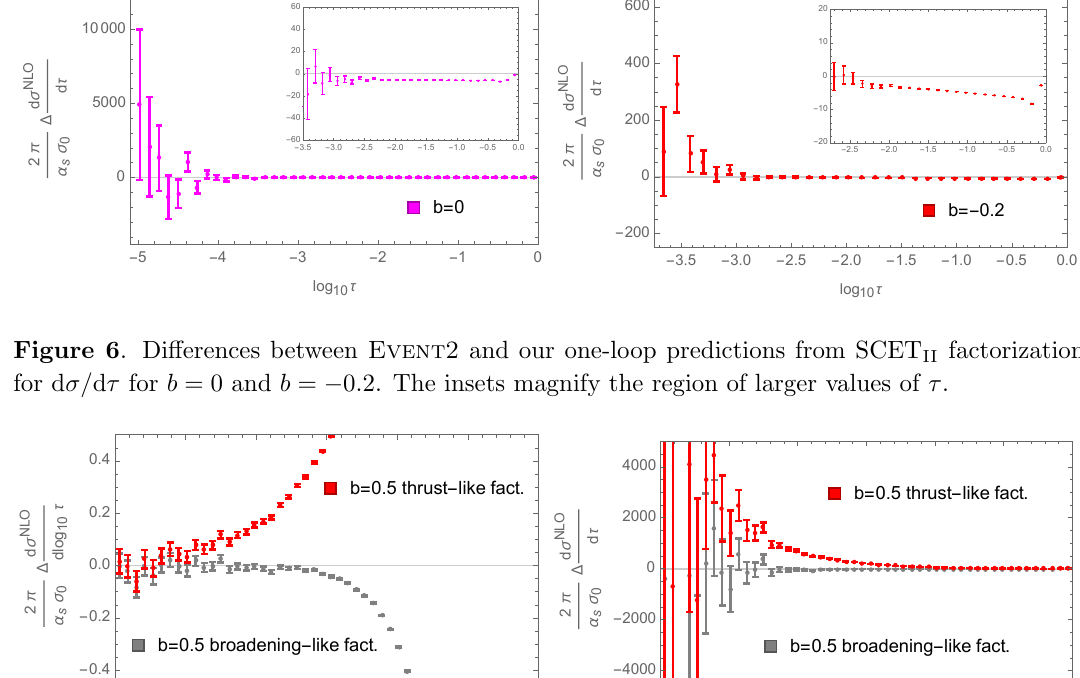
b 0.5 broadening =